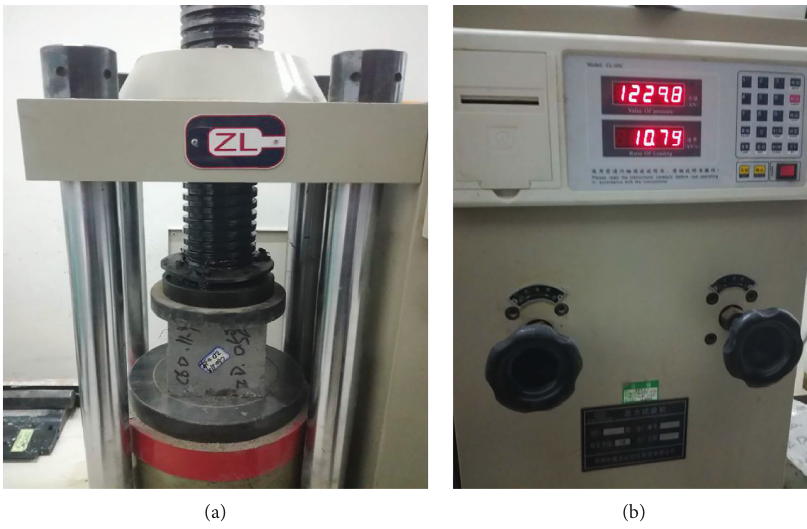
Figure 5: Cube compressive strength testing